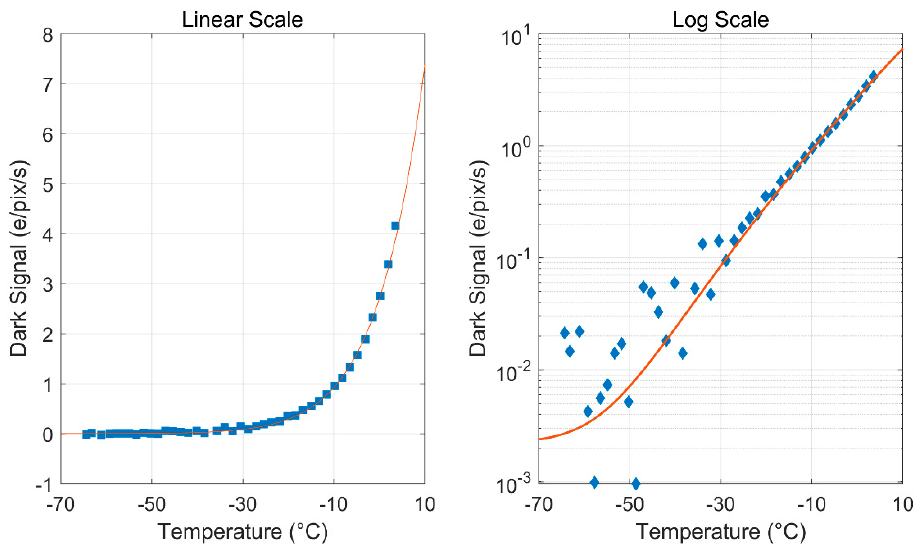
Figure 7. Dark signals as a function of temperature of blue channel AIMO CCD.